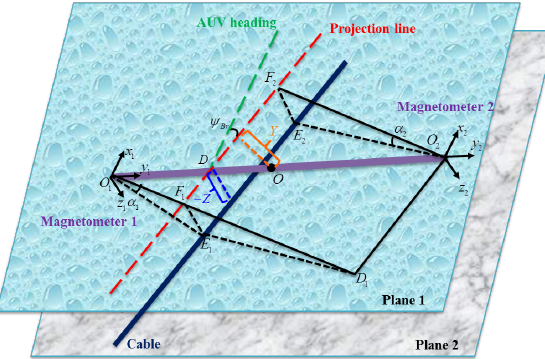
Figure 2. The yellow AUV equipped with two tri-axial magnetometers and the blue-black cable are located in Plane 1 and Plane 2, respectively. In Plane 1, the red dashed line denotes the projection line of the cable; the green dashed line denotes the AUV heading; and the purple line is the connection line between two tri-axial magnetometers, represented by O 1 x 1 y 1 z 1 and O 2 x 2 y 2 z 2 , respectively. Note that their x -axes are parallel to the longitudinal axis directed from aft to fore of the AUV and the z -axes are directed from top to bottom. Constructing the auxiliary lines as O 1 E 1 ⊥ E 1 E 2 , E 1 F 1 ⊥ O 1 F 1 , O 2 E 2 ⊥ E 1 E 2 , E 2 F 2 ⊥ O 2 F 2 and O 2 D 1 ⊥ O 1 D 1 gives the following geometrical relationships for locating the cable: (1) F 1 E 1 = F 2 E 2 = − Z ; (2) (cid:52) O 1 DF 1 ∼ (cid:52) O 2 DF 2 ; (3) F 1 D 1 = O 2 F 2 ; (4) ∠ O 2 O 1 D 1 = ψ Br